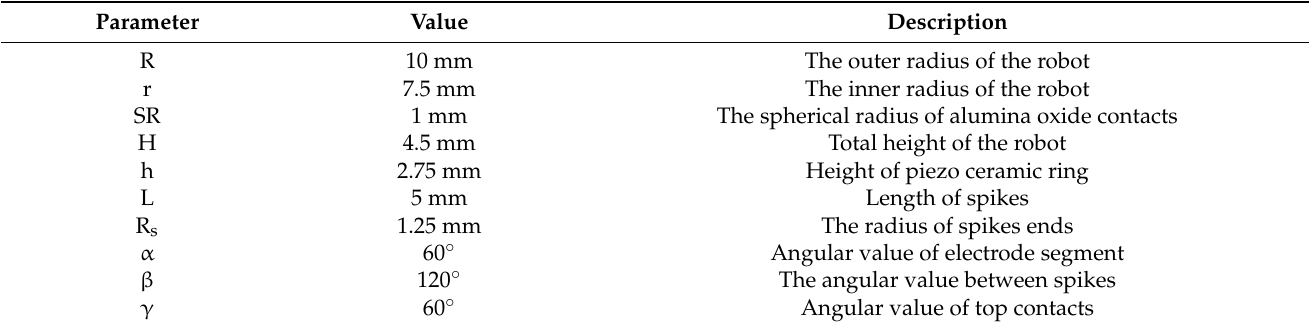
Table 1. Geometrical parameters of the robot.